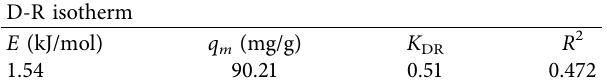
Table 2: D-R isotherm